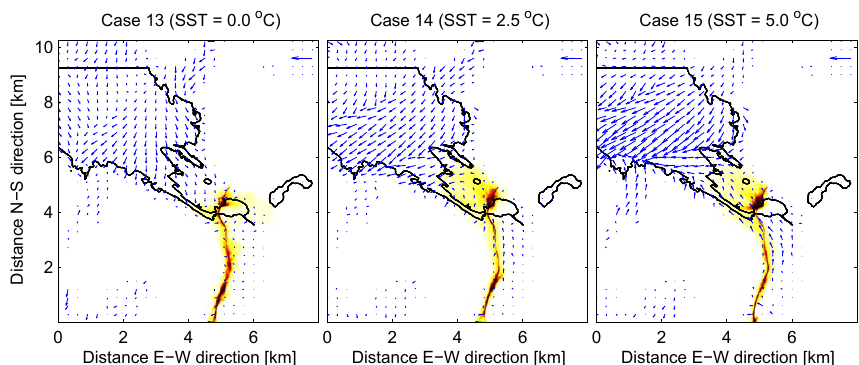
Figure 9. Same as Fig. 7 but for the cases with emissions only from the main street inside the Bergen Valley. The colour coding for the concentration is the same in all three panels, but different from Fig. 7. Shading is chosen to show the horizontal distribution of the pollutants and not the maximum values over the